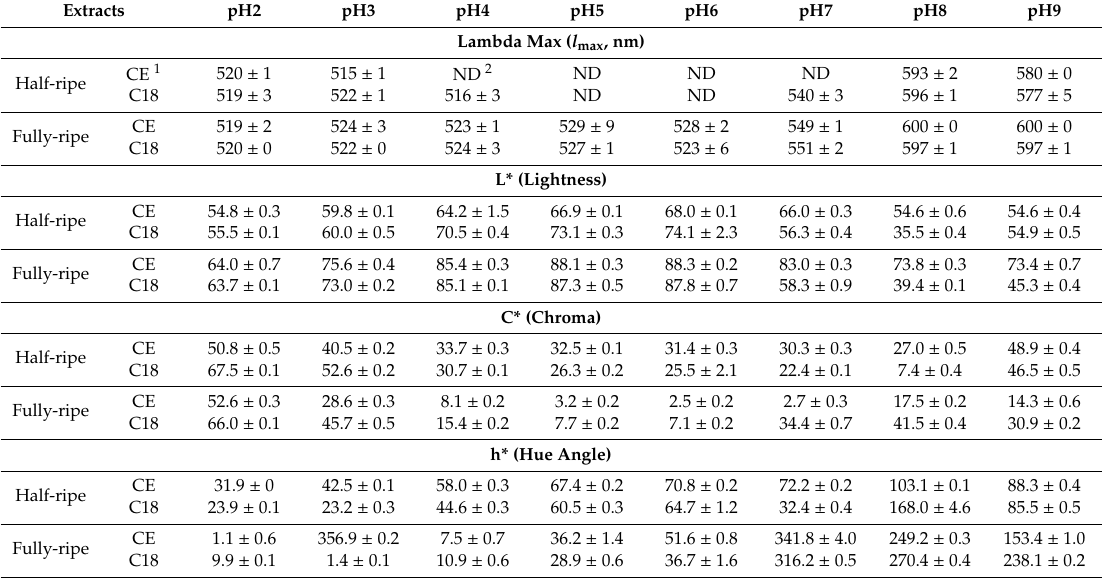
Table 3. Spectrophotometric ( l vis-max , nm) and colorimetric (CIE-L*, C*, h*) data of half and fully-ripe ‘Nova’ extracts before and after C-18 semi-purification in pH 2–9 bu ff ers ( n = 3). Data was collected 1 h after